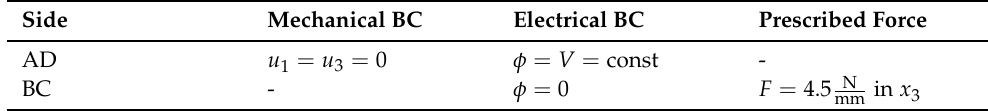
Figure 28. Truncated pyramid model with compressive load on top. Table 3. Boundary conditions for the truncated pyramid.